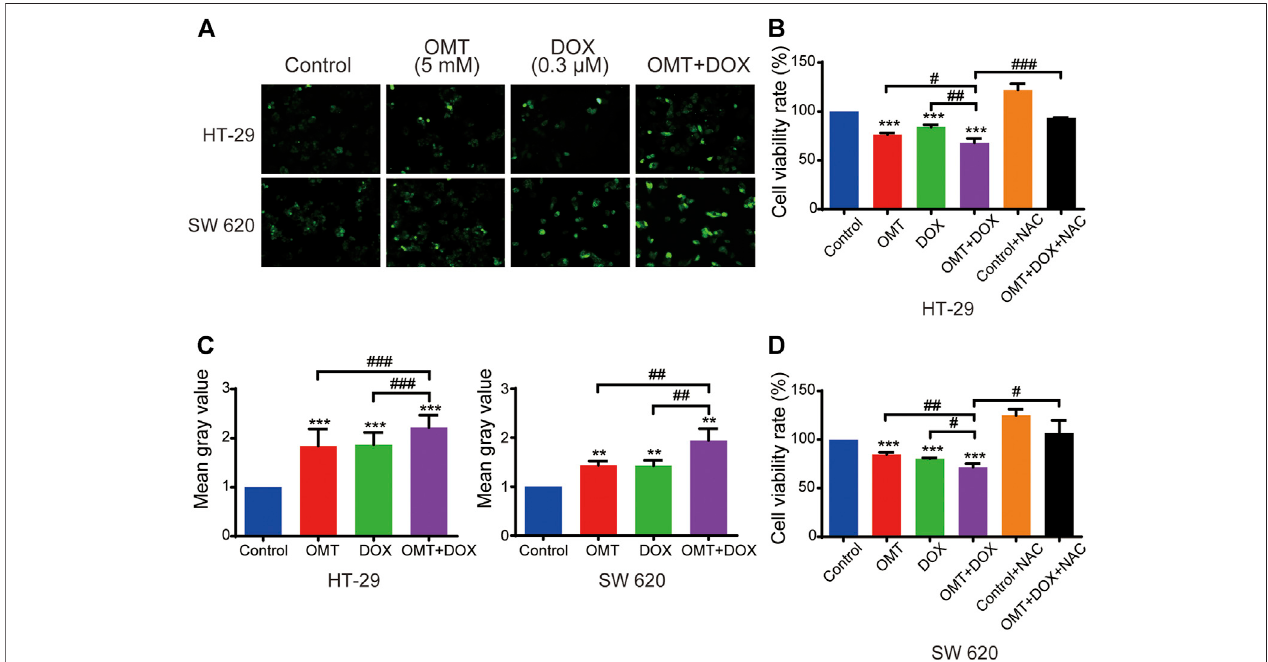
FIGURE 5 | OMT and DOX act synergistically to upregulate ROS levels in CRC cells. (A) Intracellular ROS detection after treatment with OMT, DOX, or OMT plus DOX. (B) Analysis of cell viability after exposure to OMT and/or DOX in the presence or absence of NAC. (C) ImageJ was used to calculate green fl uorescence intensity. (D) AnalysisofcellviabilityafterdealtwithOMTand/orDOXinthepresenceorabsenceofNAC.Dataarepresentedasthemean ± SDofthreeindependentexperiments. ** p < 0.01, *** p < 0.001 vs. the control group; # p < 0.05, ## p < 0.01, ### p < 0.001 vs. the OMT (5 mM) group, DOX (0.3 μ M) group, or OMT plus DOX.